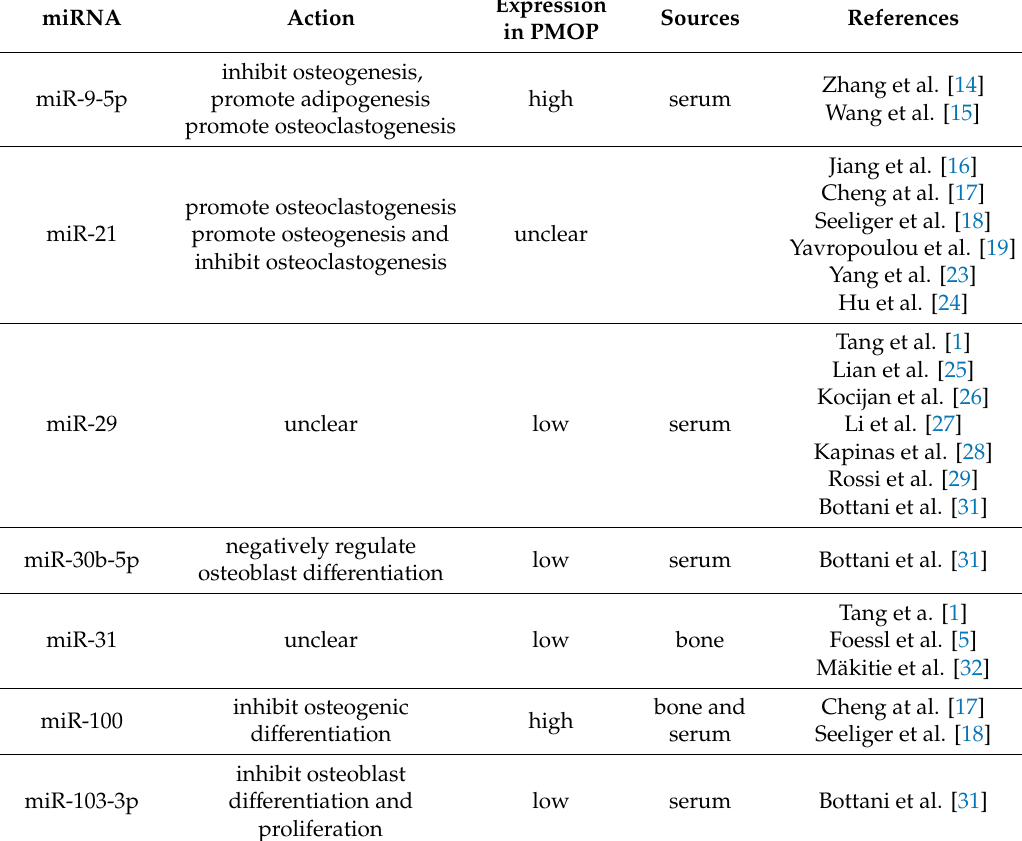
Table 1. List of micro RNAs (miRNAs), their actions, and expression in postmenopausal osteoporosis (PMOP). Studies were performed in humans unless otherwise stated in parentheses. Expression miRNA Action in PMOP